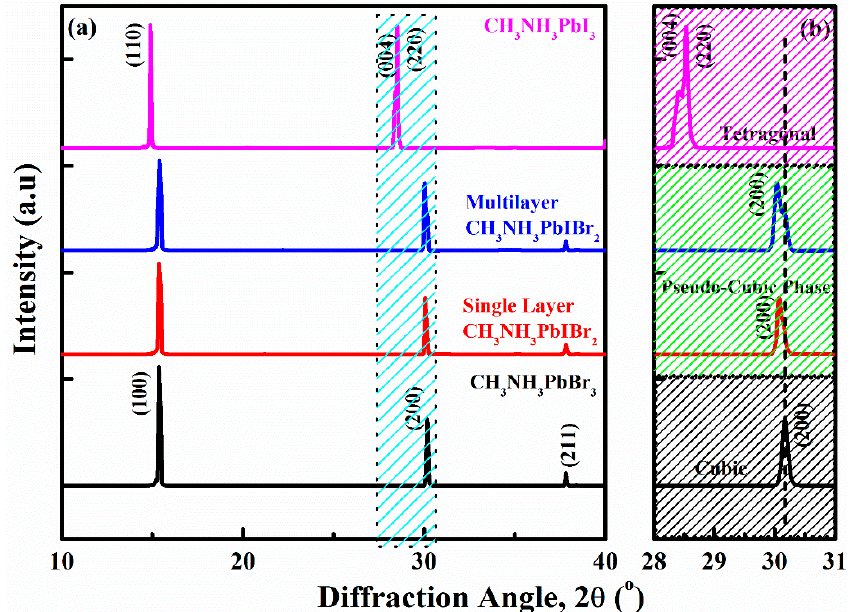
Figure 1. ( a ) XRD analysis of CH 3 NH 3 PbI 3 thinfilm (as a reference at top), CH 3 NH 3 PbBr 3 thinfilm (as a reference at bottom), single-layer and multilayered CH 3 NH 3 PbIBr 2 thinfilms (at center). ( b ) Amplified XRD image from 2 θ = 28–31° to observe the pseudo-cubic phase for single-layer and multilayered CH 3 NH 3 PbIBr 2 thinfilms.